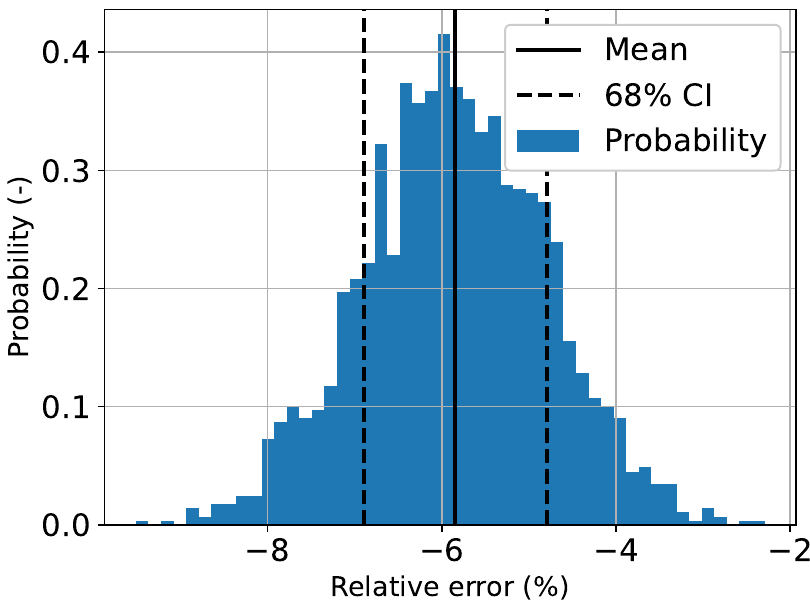
Figure 9. The probability distribution of the relative wake model error (cid:101) , including the mean value and 68% confidence